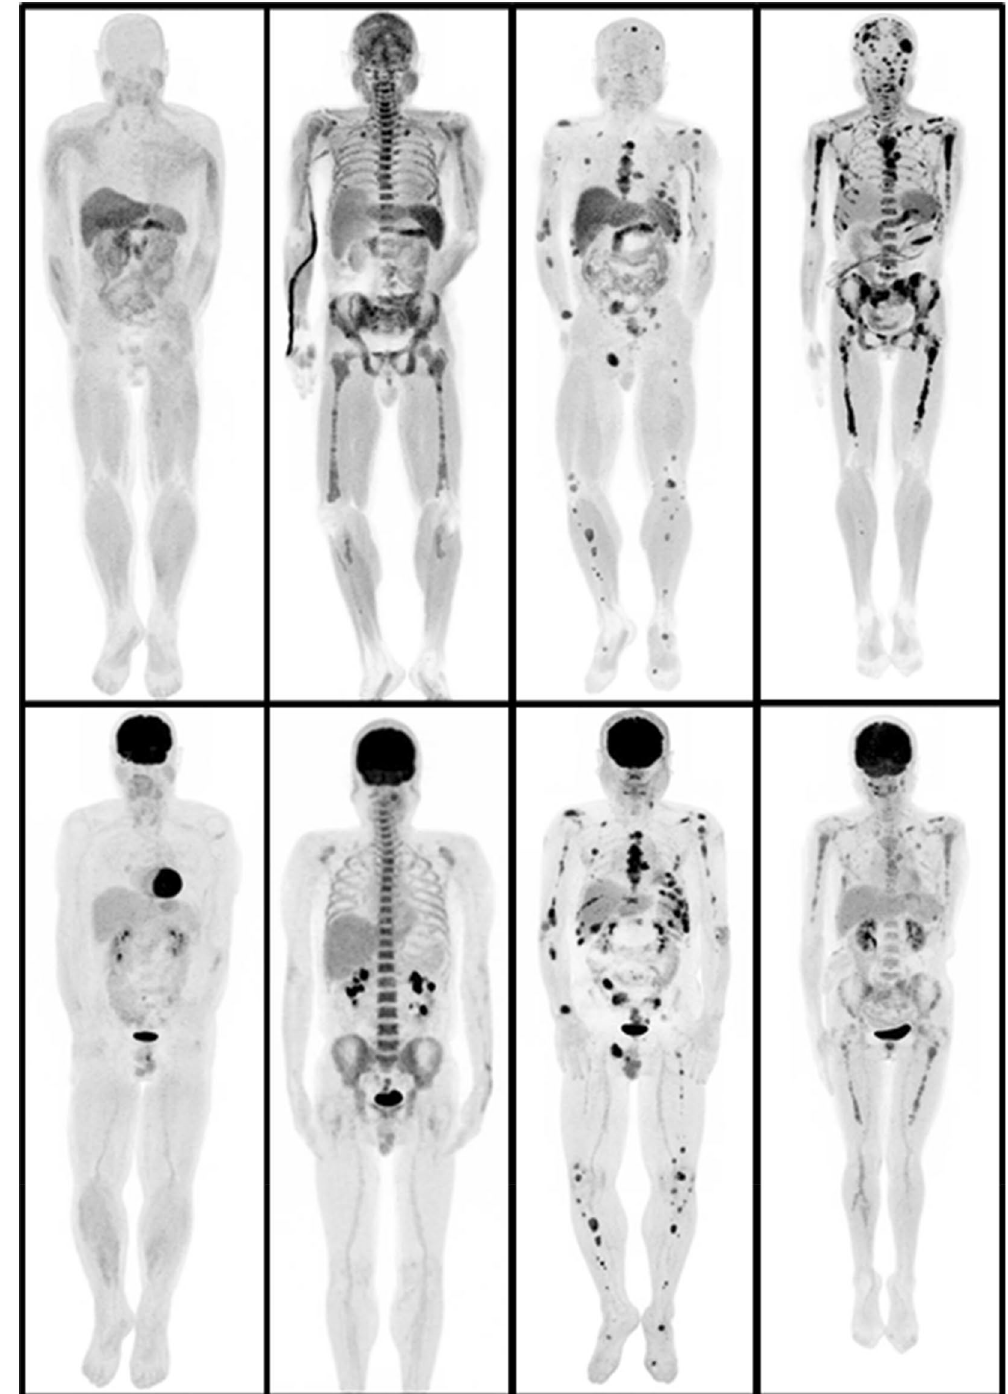
Figure 1. Maximum-intensity-projection images of 11 C-acetate (upper row) and 18 F- fluorodeoxyglucose (FDG) (lower row) positron-emission tomography (PET). Bone marrow involvement is shown as negative uptake, diffuse involvement, focal lesions, and diffuse + focal lesions from left to right. (Images by MIM Encore of MIM Software Inc., version number: 6.6.11_buildH213-00, URL: https:// www. mimso ftware.